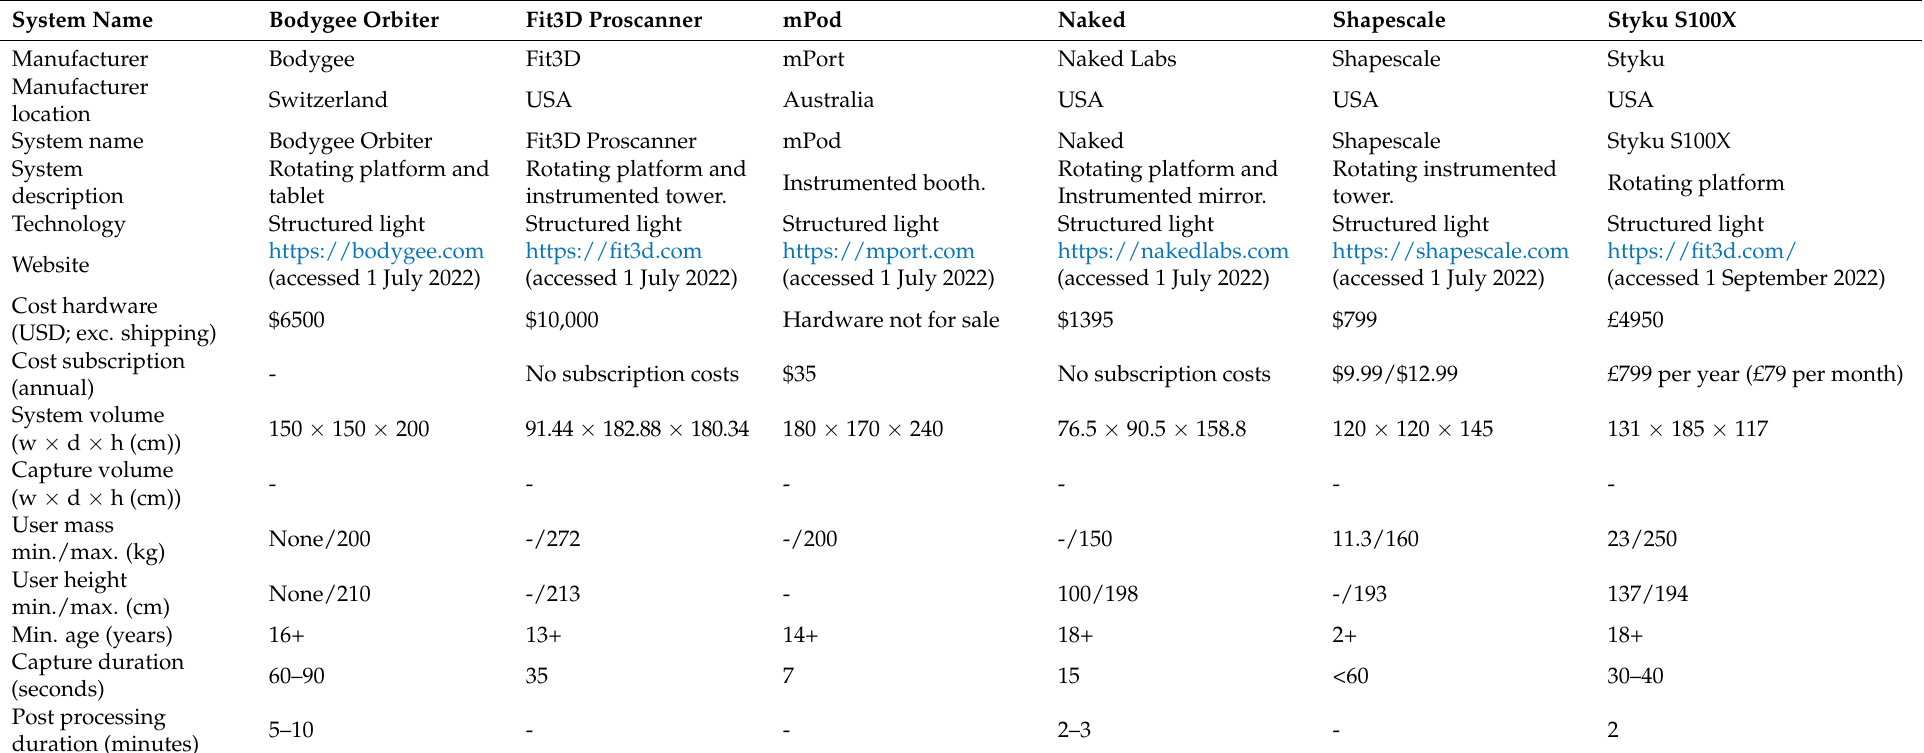
Table 1. The user and system details for 3D surface imaging systems with the body composition estimation capability, in which “-“ represents not